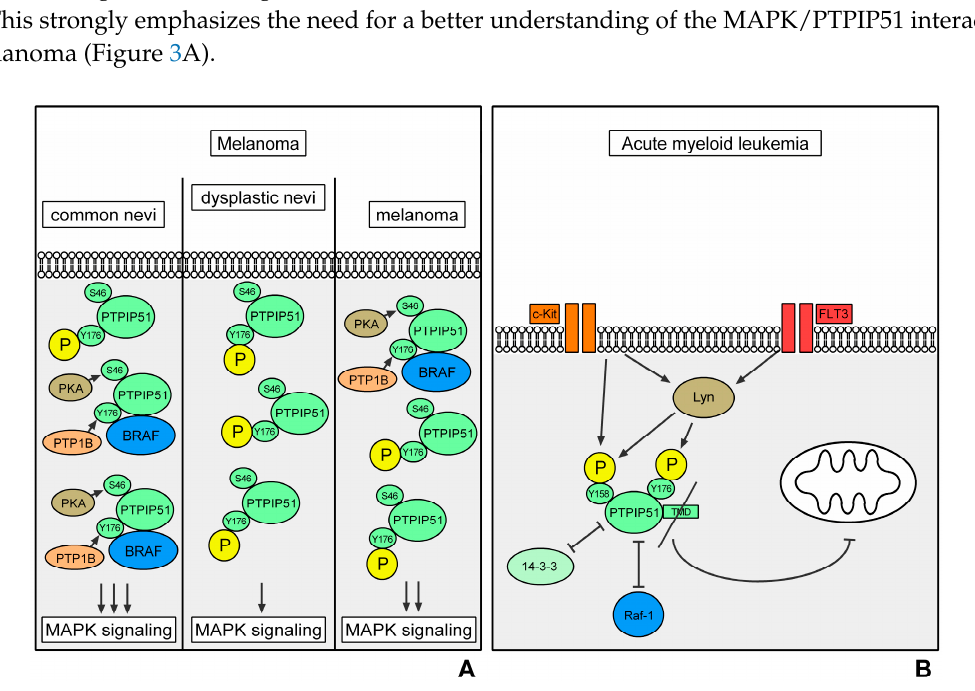
Figure 3. Regulation of PTPIP51 in melanoma. The left panel depicts the regulations of PTPIP51 in normal nevi. The phosphorylation level of the Tyr176 residue is low due to the high interaction with PTP1B. The phosphorylation of the Ser46 residue of PTPIP51 via PKA and the low phosphorylation level of the Tyr176 residue induce the formation of the PTPIP51/14-3-3 β (not depicted)/BRAF complex and thereby a stimulation of the MAPK pathway. In the progression of the dysregulation of signaling as represented by the dysplastic nevi, the phosphorylation of PTPIP51 at Tyr176 is upregulated and thus inhibits the MAPK pathway stimulation of PTPIP51. This potentially mirrors a counter-regulation against the dysregulated growth and proliferation signaling in dysplastic nevi (middle panel). In melanoma cells the regulation of the phosphorylation and the interactions of PTPIP51 lie in between the normal nevi and the dysplastic nevi. This depicts the complete dysregulation of signaling since the counter-regulation of MAPK pathway via PTPIP51 phosphorylation is also deregulated (black arrows indicate a phosphorylation/interaction) ( A ); regulation of PTPIP51 interactions in acute myeloid leukemia. Activating mutations of the FMS like tyrosine kinase 3 (FLT3) receptor induce an activation of the Src family kinase Lyn. Lyn phosphorylates the Tyr158 and the Tyr176 residue of PTPIP51, which inhibit the formation of the Raf-1/14-3-3 β /PTPIP51 complex and thus the MAPK pathway stimulation of PTPIP51. In acute myeloid leukemia blasts the N-terminus of PTPIP51 is missing. Therefore, the PTPIP51 protein does not contain the TMD. Due to the loss of the TMD a translocation to the mitochondrion is not possible and the apoptosis-inducing function of PTPIP51 is omitted (black arrows indicate a phosphorylation/activation, arrows with vertical bar as arrow head indicate an inhibition of interaction/activation) ( B